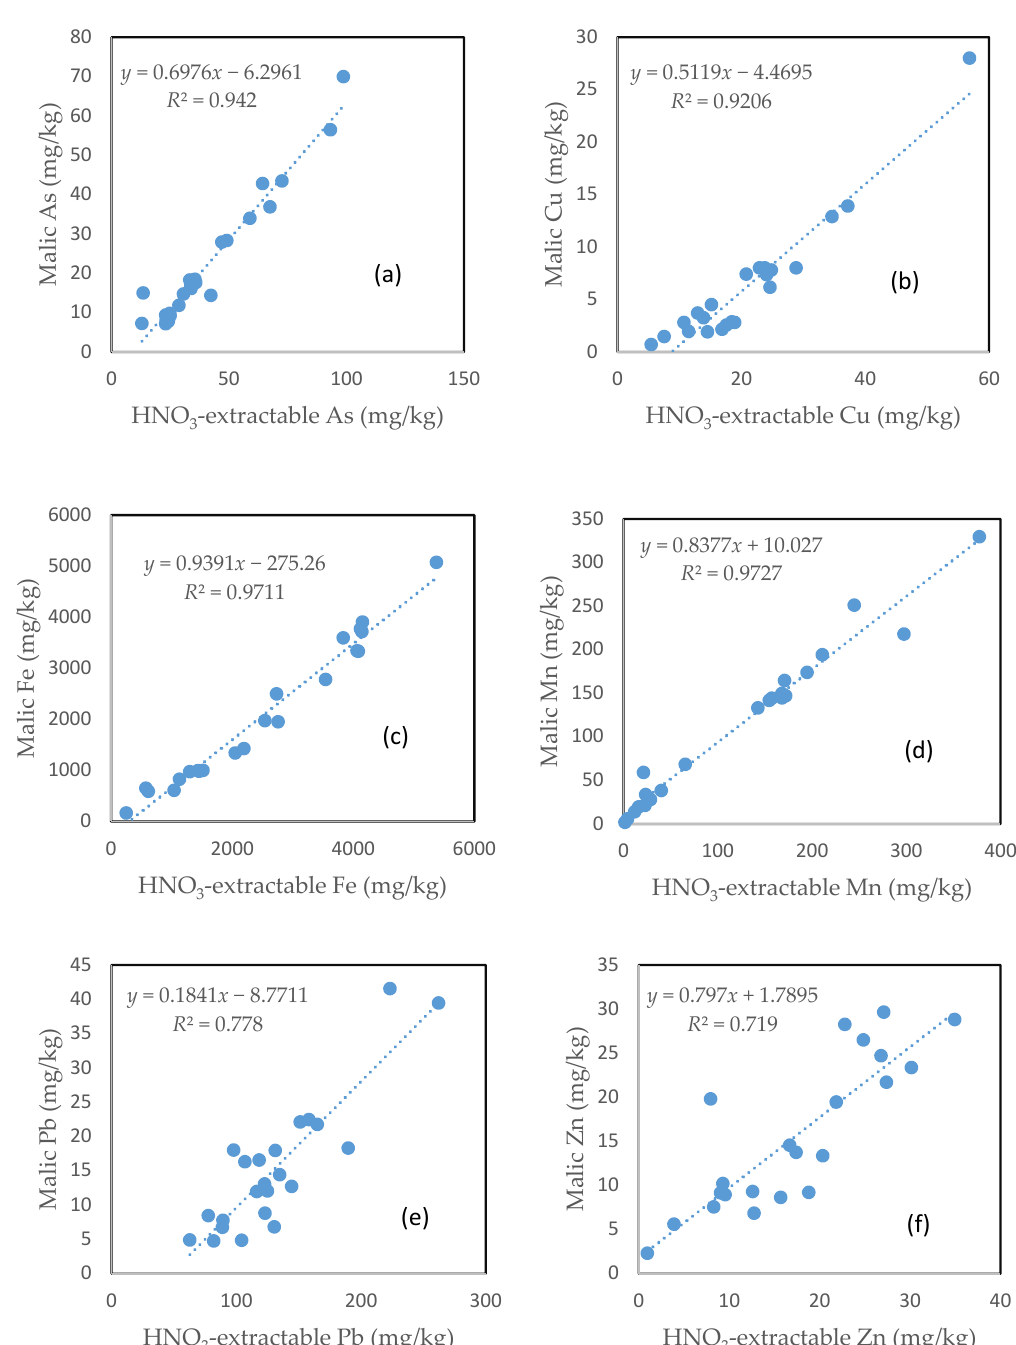
Figure 8. Relationship between the HNO 3 -extractable fraction and the malic acid-extractable fraction for ( a ) As, ( b ) Cu, ( c ) Fe, ( d ) Mn, ( e ) Pb, and ( f ) Zn.